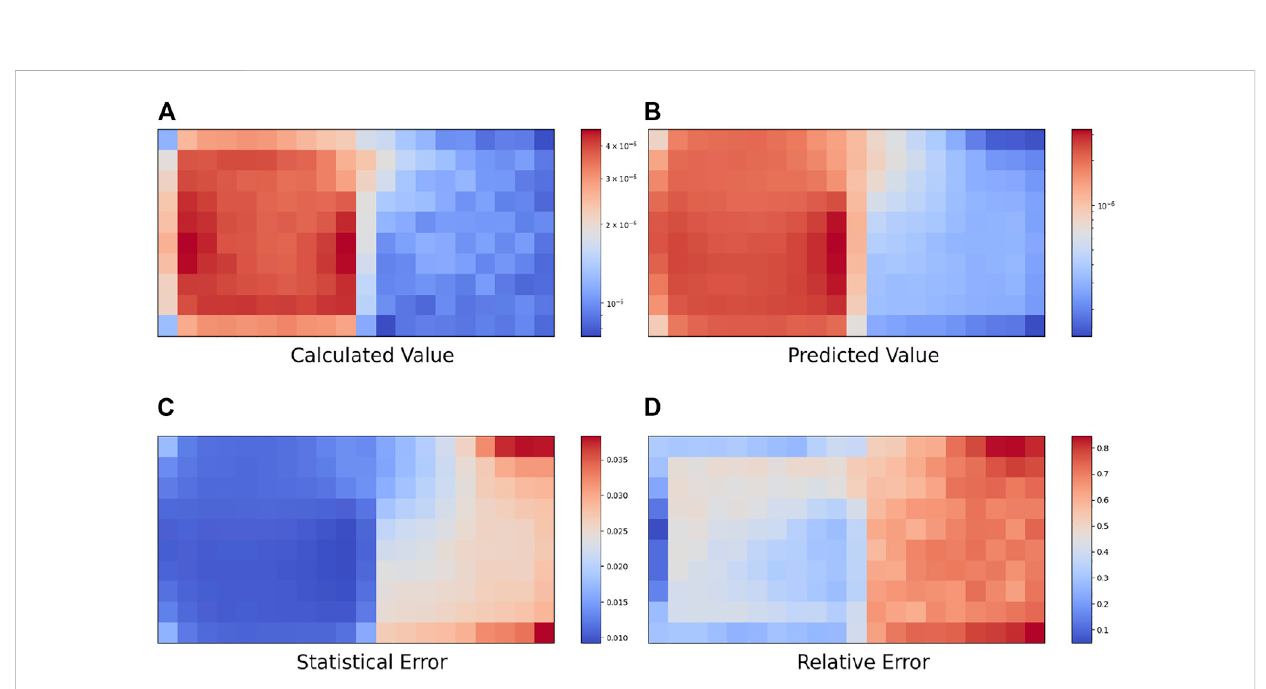
FIGURE 12 Reconstruction results of the 3D cylindrical source